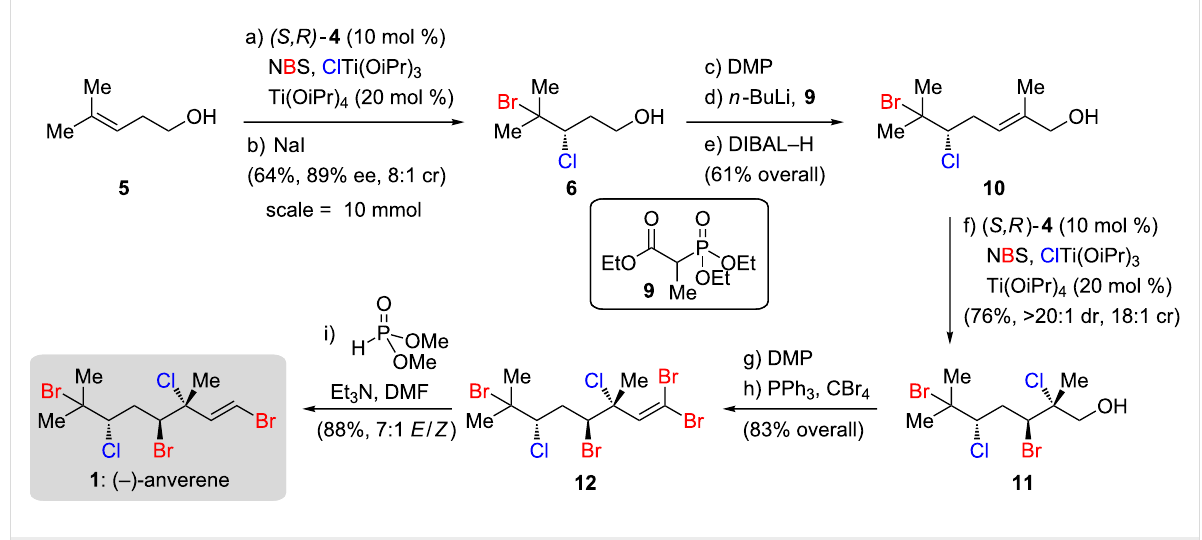
Scheme 2: Selective total synthesis of ( − )-anverene. Reagents and conditions: a) NBS (1.2 equiv), ClTi(OiPr) 3 (1.1 equiv), 20 mol % Ti(OiPr) 4 , 10 mol % ( S,R )- 4 , 0.025 M hexanes, − 15 °C, 17 h; b) NaI (2 equiv), acetone, 65 °C, 3 h; c) Dess–Martin periodinane (1.2 equiv), NaHCO 3 (5 equiv), CH 2 Cl 2 , 0 °C to rt; d) triethyl 2-phosphonopropionate 9 (1.5 equiv), n -BuLi (1.2 equiv), 1:1 THF/acetonitrile, 0 °C, 5 min; e) DIBAL − H (3 equiv),